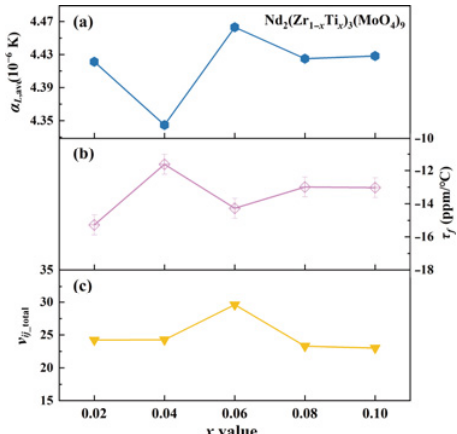
Fig. 10 (a) α L ,ave , (b) τ f , and (c) total bond valences ( v ij _total ) of NZ 1 − x T x M ( x = 0.02–0.10) ceramics sintered at optimal temperatures.